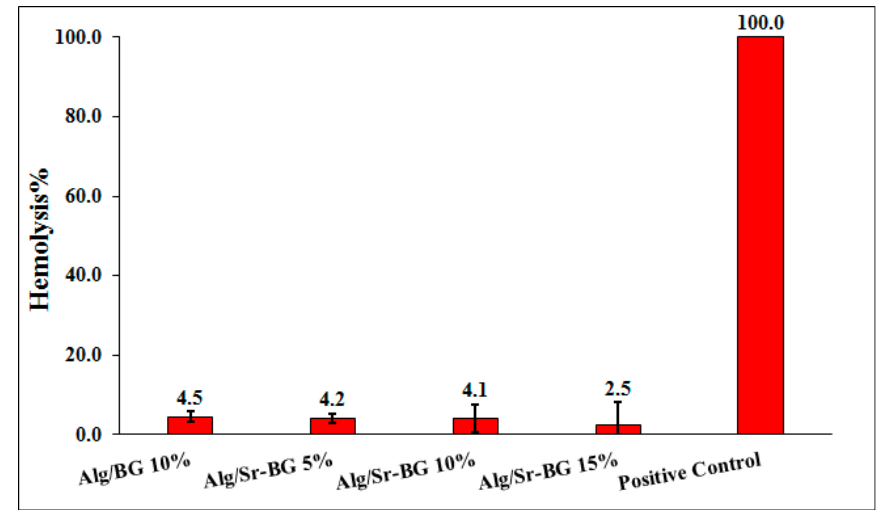
Figure 9. Hemolysis percentage of the prepared gel composites compared to positive control.